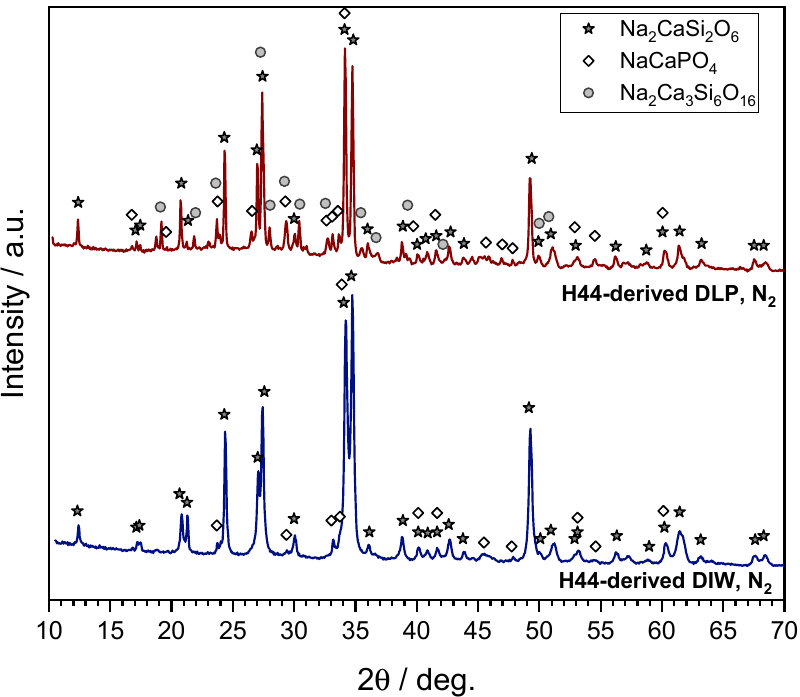
Figure 12. Results of mineralogical analysis of polymer-derived Biosilicate ® -like/C scaffolds from H44-based mixtures: comparison of scaffolds from DIW and DLP.